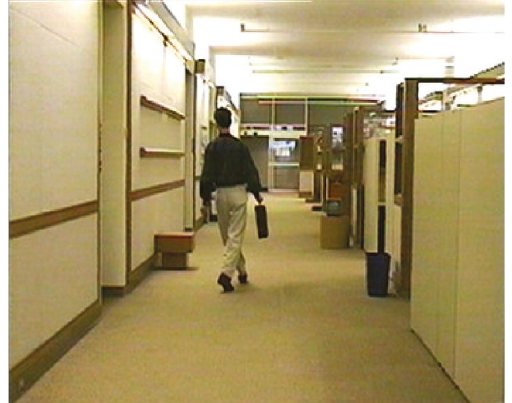
Figure 8: A picture from the “hall monitor” test sequence.